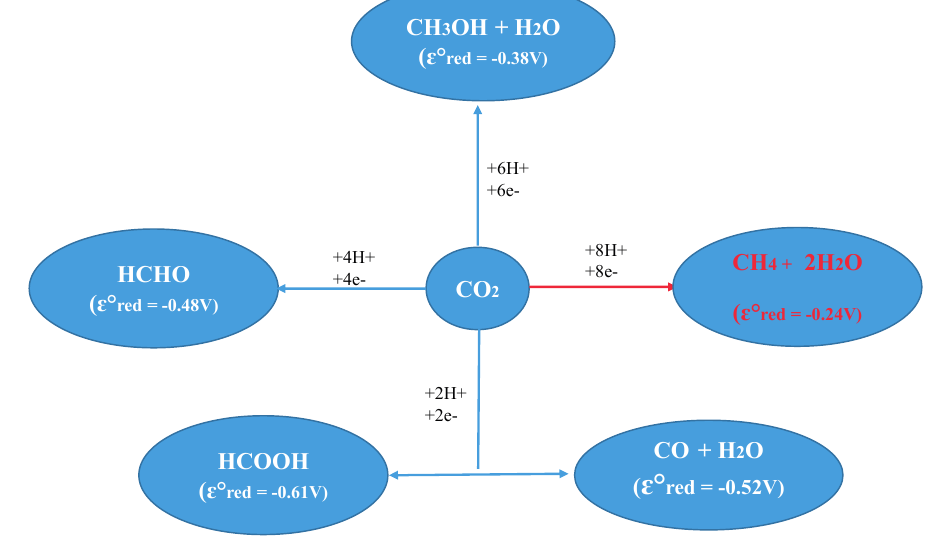
Figure 3. Photocatalytic reduction of CO 2 to fuels